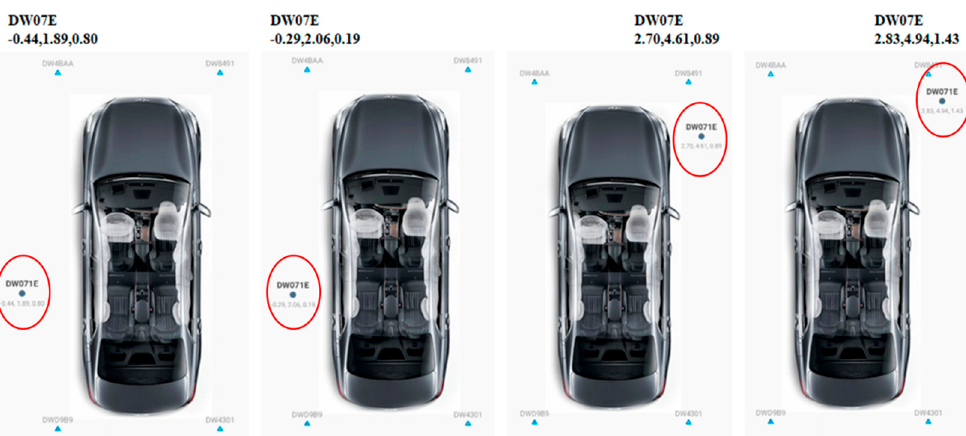
Figure 12. Monitoring display of the position of the tool (red circle).